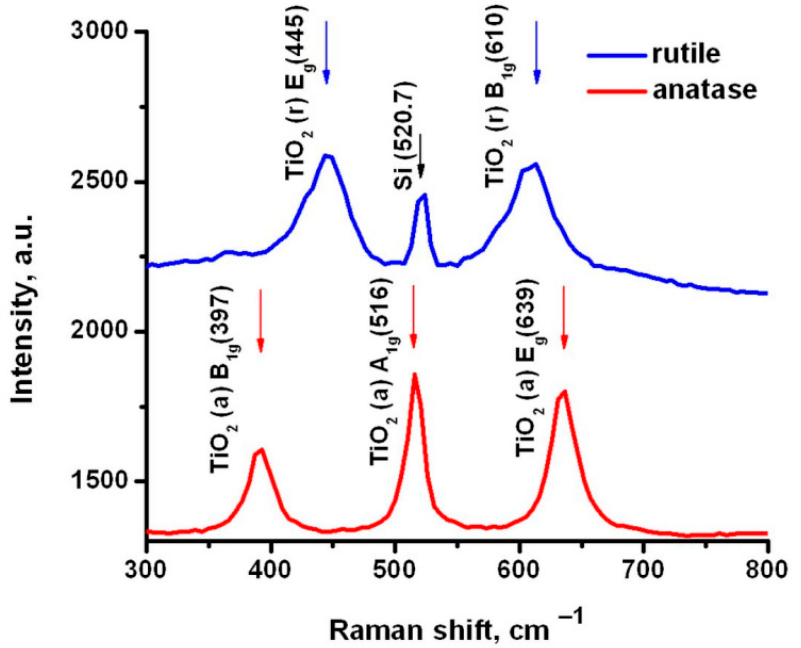
Figure 1. Raman spectra of Rutile TiO 2 (r) and Anatase TiO 2 (a) NP with 488 nm wavelength laser excitation. The peaks, positions, and modes are marked according to literature values.